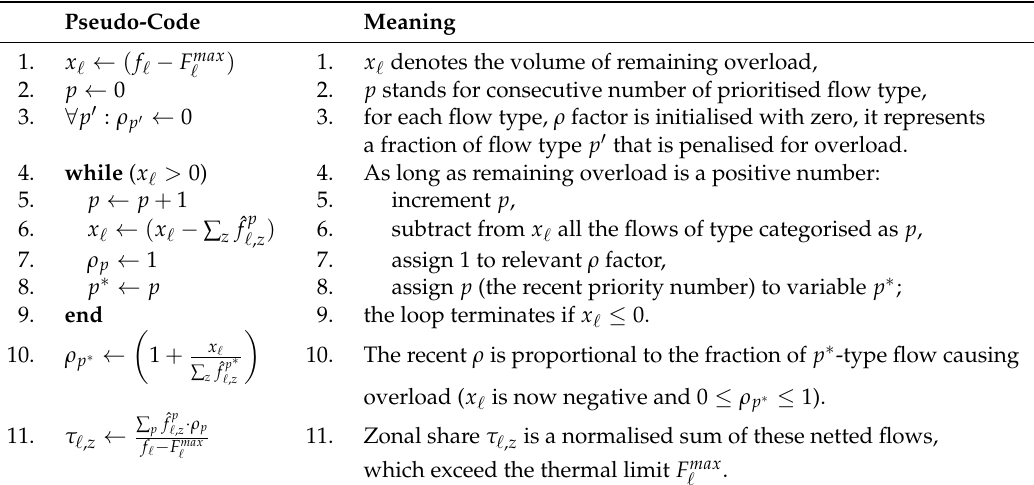
Table A1. Algorithmic description of the final step of transformation. The procedure is aimed at finding values of ρ p and using them to determine τ (cid:96) , z (line